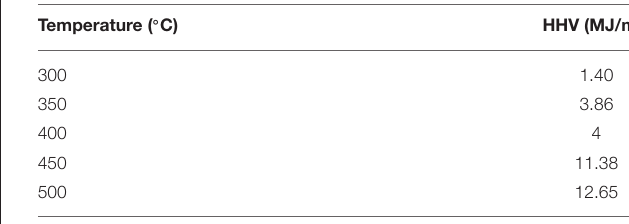
TABLE 5 | Ultimate analysis of solid residues from pretreated ASR pyrolysis at 500 ◦ C. Ultimate analysis (dry basis